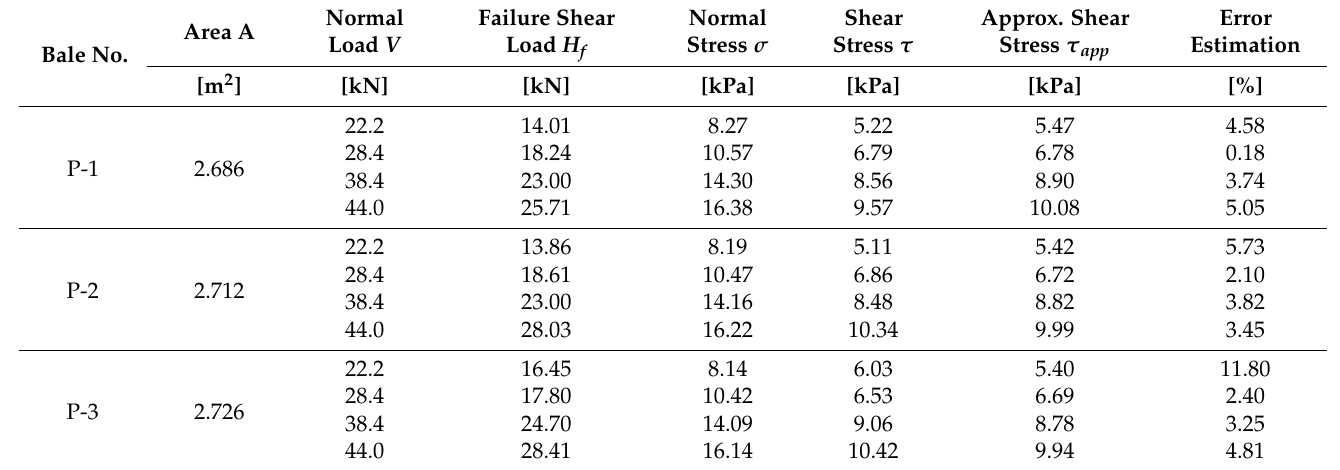
Table 6. Shear and normal stresses along the tyre bale–soil